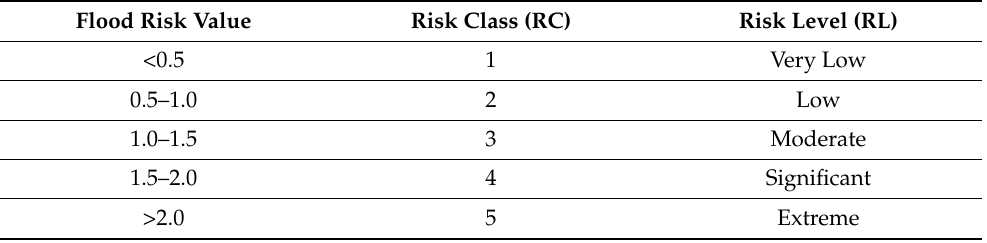
Table 2. Classes of flood risk in Manafwa, which results from the product of hazard and vulnerability.